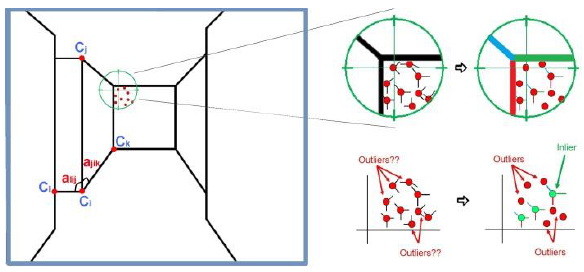
Figure 5. Left: angles between connected corners and structural corner point candidates are identified around the projected layout corner. Right: candidate corner points are classified by considering the orientation of their supporting line